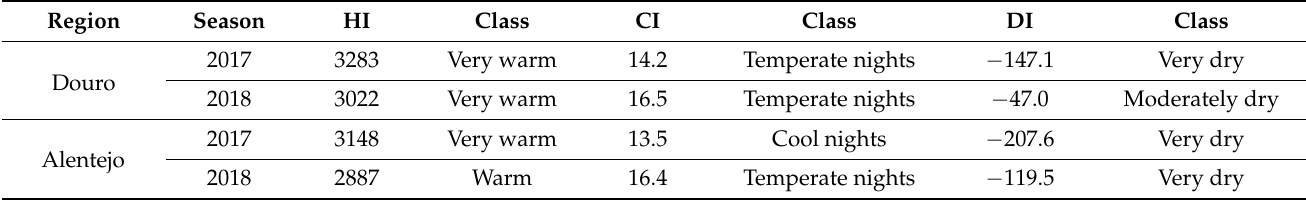
Table 1. Huglin Heliothermal Index (HI), Cool Night Index (CI, ◦ C), and Dryness Index (DI, mm) values for 2017 and 2018 growing seasons in the Douro and Alentejo sites were considered according to Tonietto and Carbonneau [18]. Region Season HI Class CI Class DI Class 2017 3283 Very warm 14.2 Temperate nights − 147.1 Very dry Douro 2018 3022 Very warm 16.5 − 47.0 Moderately dry 2017 Very warm Very dry Alentejo 2018 2887 Warm 16.4 Temperate nights − 119.5 Very